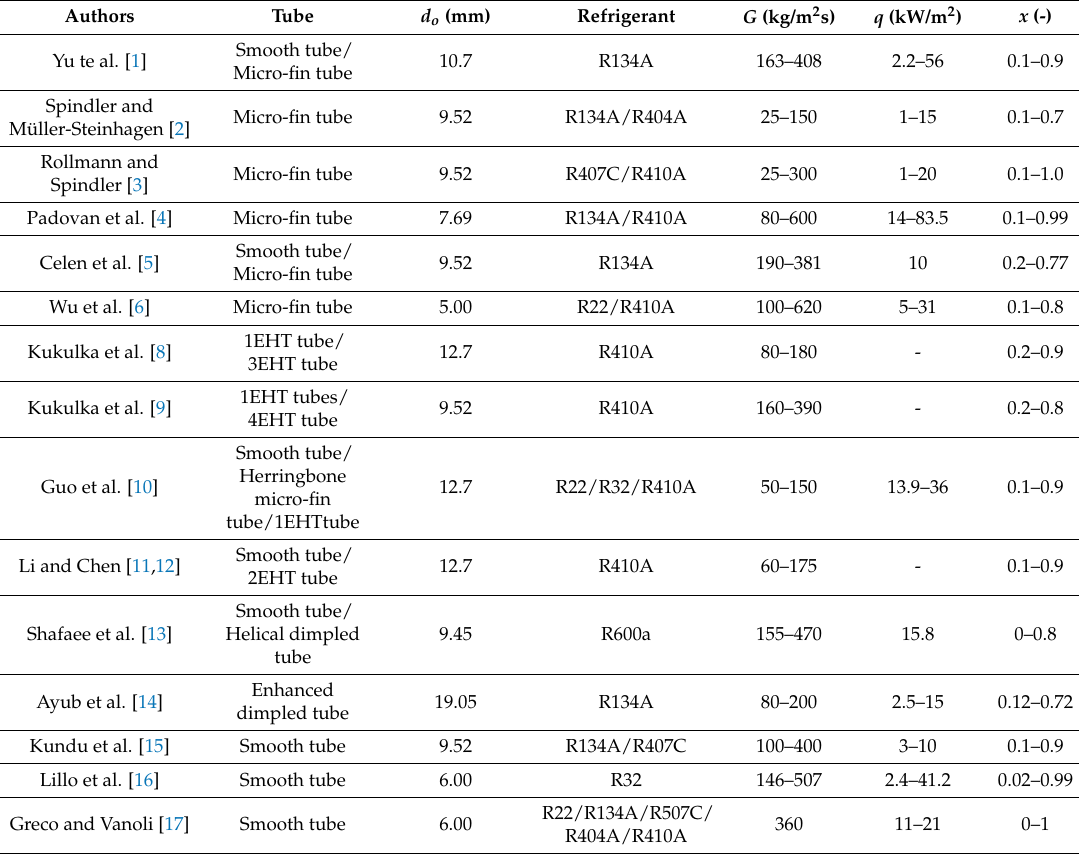
Table 2. Summary of previously published studies on evaporation inside a